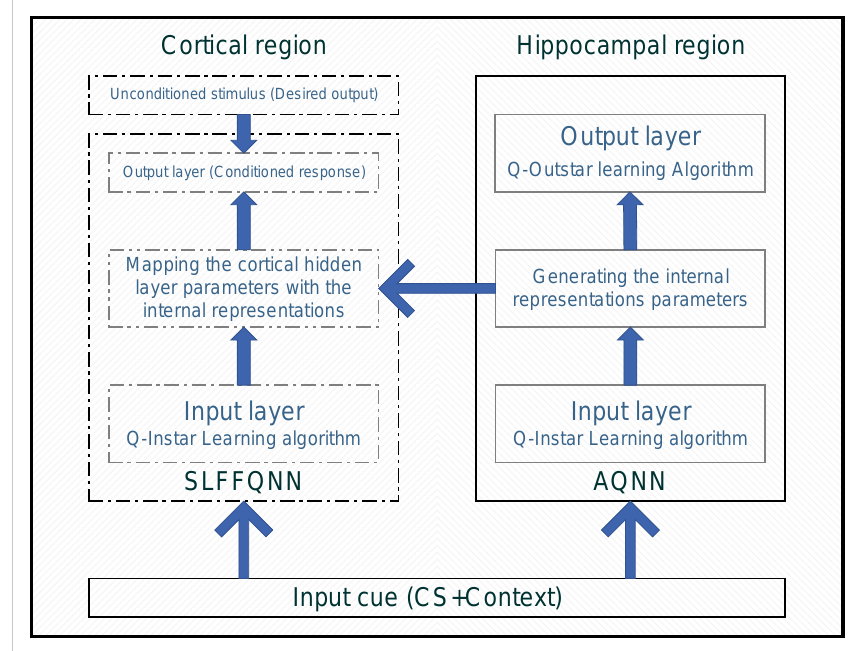
Figure 2. The CHCQ model